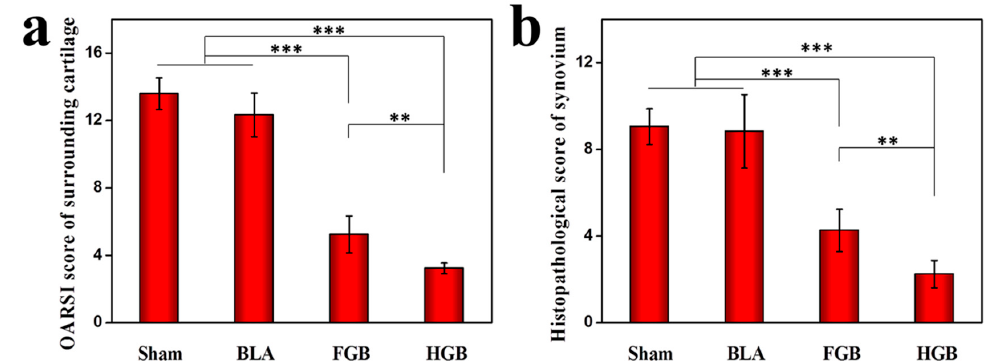
Figure 9. Sections of tissues surrounding cartilage and typical synovium tissue in each group stained with H&E at 12 weeks post-transplantation (Magnification: 40×). The black arrow indicates the infiltration of inflammatory cells and the yellow arrow indicates hyperplasia of synovial lining. Polymers 2016 , 8 , 182 12 of 15